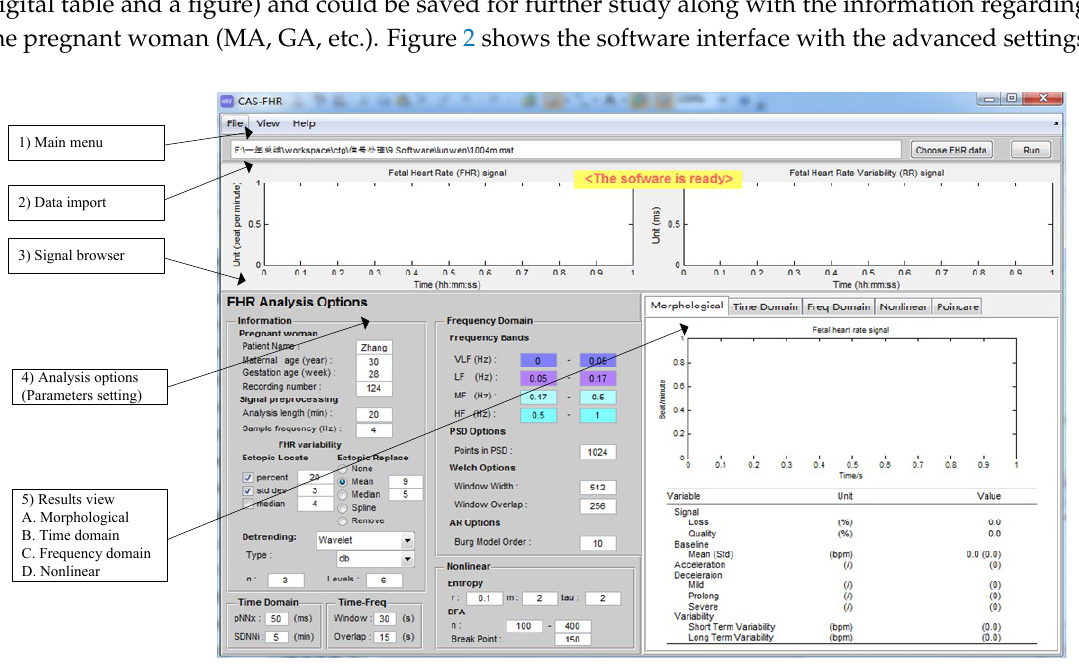
Figure 2. The graphical user interface of the computerized analysis software of the FHR signal (CAS‐FHR) is divided into five segments: ( 1 ) Main menu; ( 2 ) Data import; ( 3 ) Signal browser; ( 4 ) Analysis options (Parameter settings); and ( 5 ) Results viewer. The results viewer can be further divided into morphological, time and frequency domain and nonlinear results.